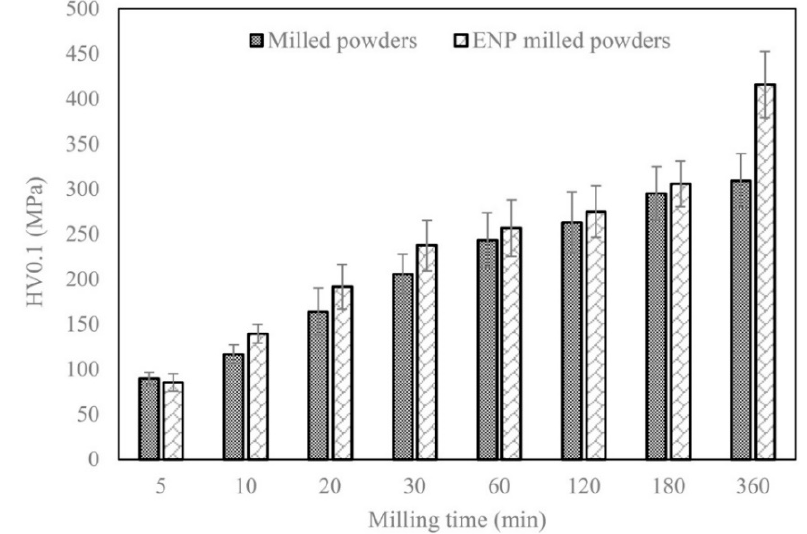
Figure 5. The variation in microhardness of both types of samples milled for different times.